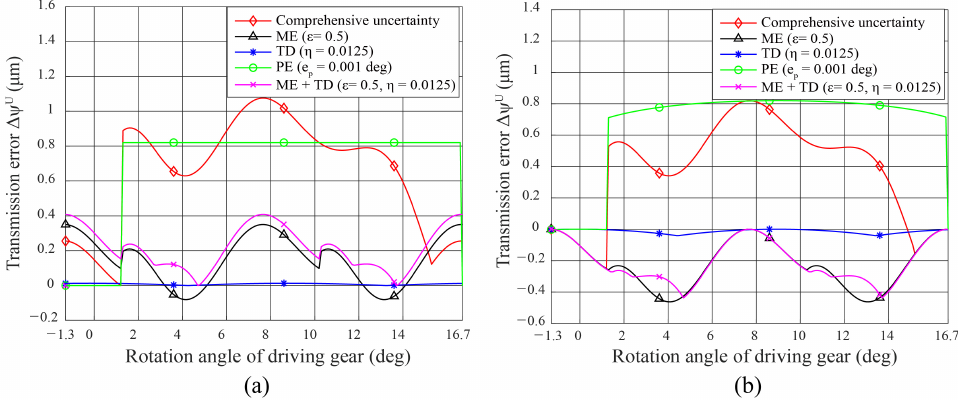
Figure 18. Transmission error of steel spur gear pair under ( a ) unloaded and ( b ) loaded conditions (Comprehensive uncertainty: (cid:101) = 0.5, η = 0.0125, e p = 0.001 deg, ME : (cid:101) = 0.5, η = 0, e p = 0 deg, TD : (cid:101) = 0, η = 0.0125, e p = 0 deg, PE : (cid:101) = 0, η = 0, e p = 0.001 deg, ME + TD : (cid:101) = 0.5, η = 0.0125, e p = 0